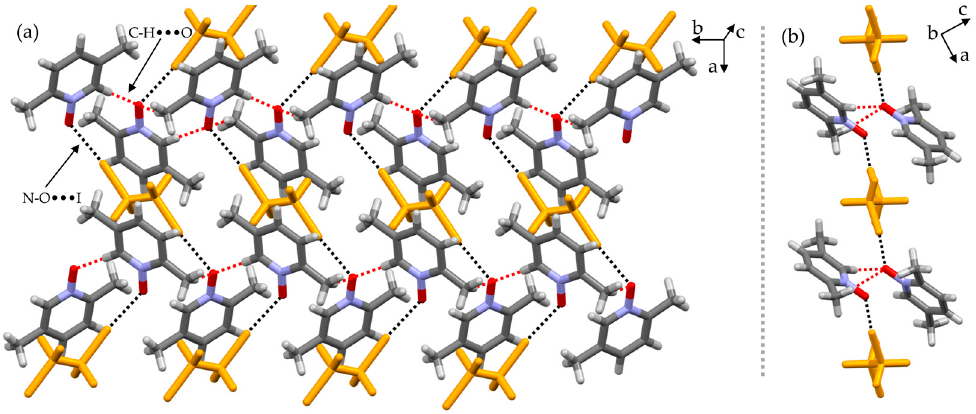
Figure 6. The 1-D Hydrogen bond tapes bridged by DI2 donors ( a ), and a view along the b-axis showing connecting modes of DI2 ( b ). Color representation: Gold capped sticks are DI2 donors, black and red broken lines are respectively XB and HB interactions.